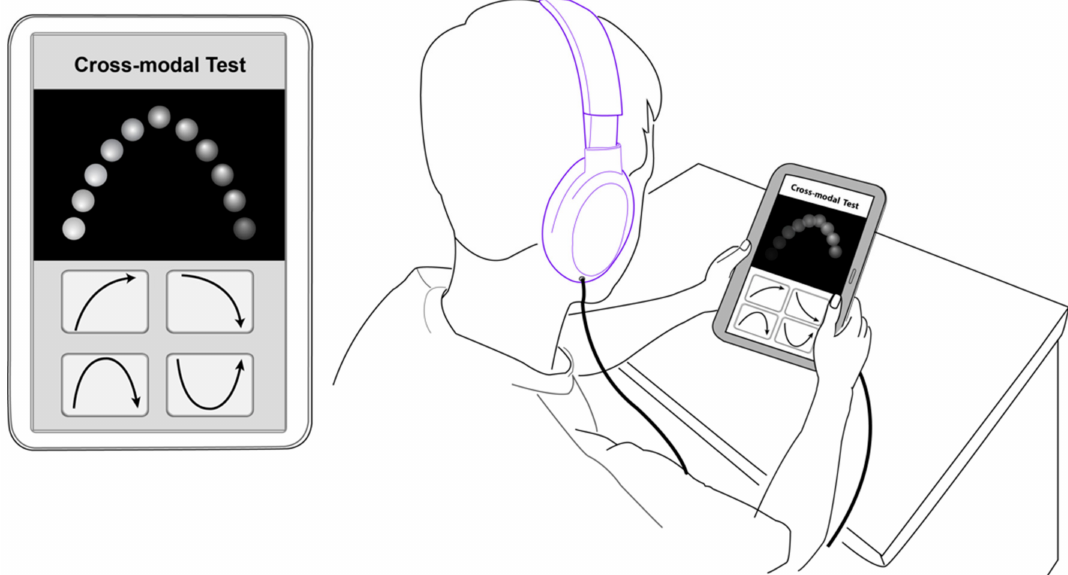
Figure 3. Audio-visual contour identification task and the experimental